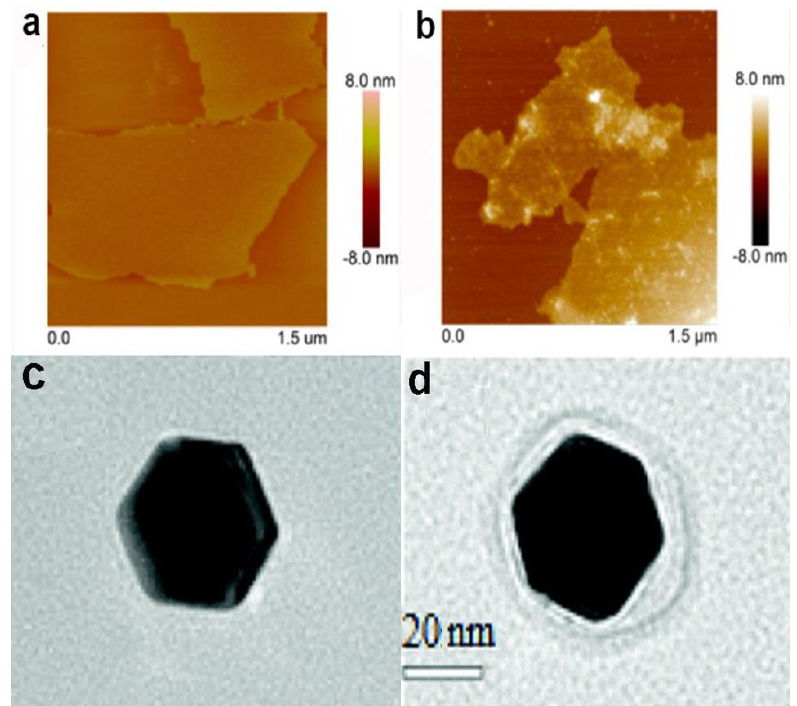
Figure 3. Atomic force microscopy (AFM) images of bare-graphene oxide ( a ) and graphene oxide – bovine serum albumin (BSA) complex ( b ). Reprinted with permission from [52]. Copyright (2015) American Chemical Society. TEM images of a single 40 nm AuNP ( c ) and 40 nm AuNP – human serum albumin (HSA) complex ( d ). Reproduced from [48] with permission from The Royal Society of Chemistry.